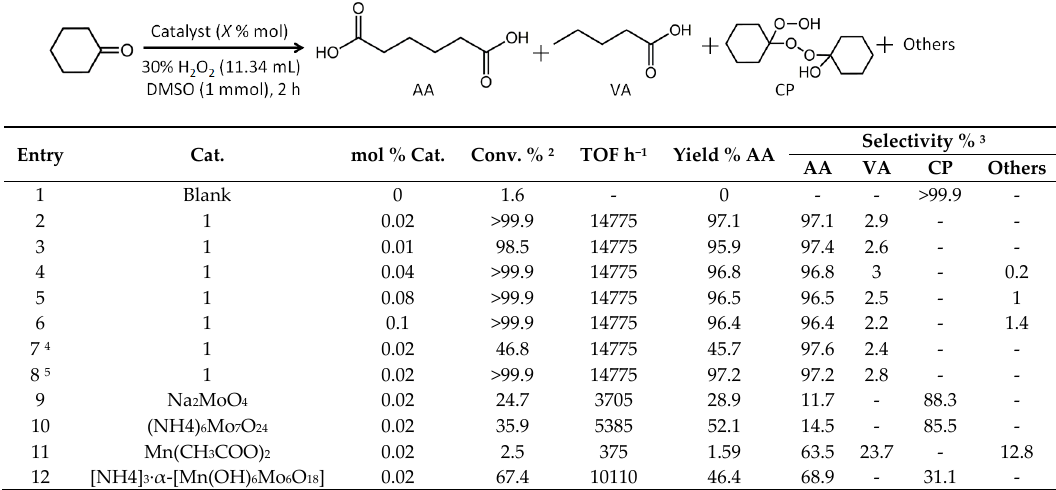
2 O 2 over catalysts.